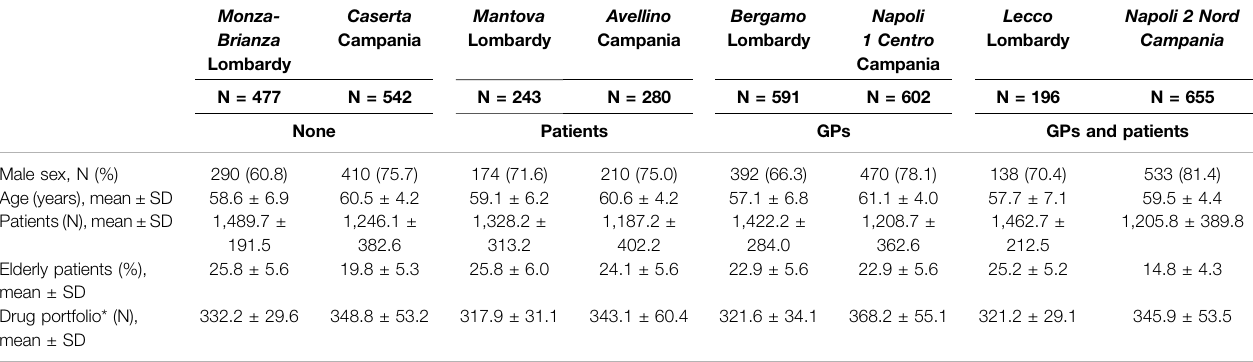
TABLE1| GPspre-interventioncharacteristicsintheeightLocalHealthUnits.Sexisreportedasfrequency(%);othervariablesareconsideredonacontinuousscaleandare reported as mean ±